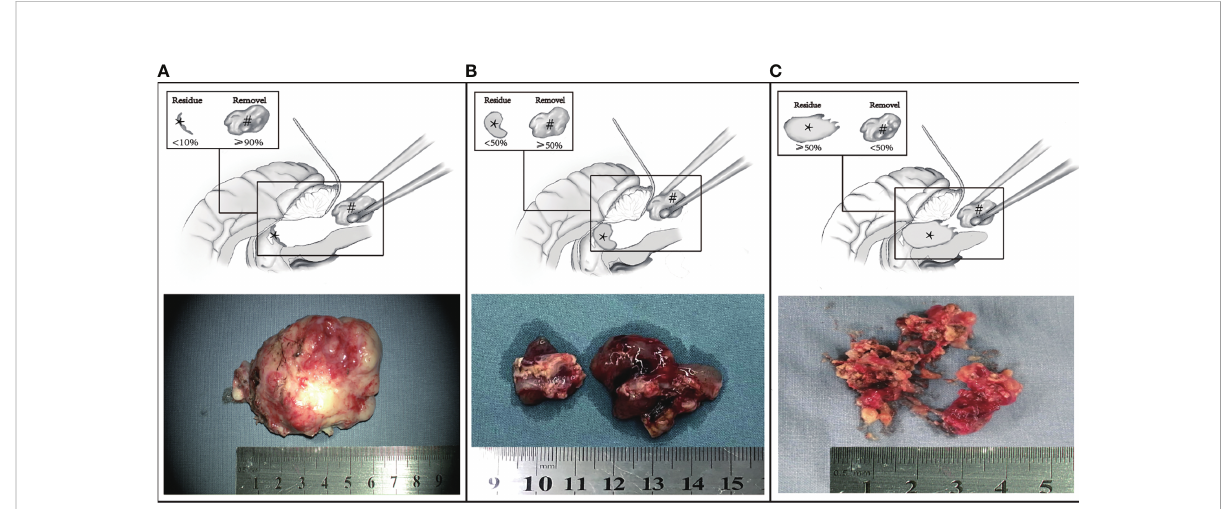
FIGURE 2 Three methods of resection. (A) Complete en bloc concept (marginal resection as a whole ≥ 90% and piecemeal resecting <10%). (B) Partial en bloc concept (marginal resection ≥ 50% and <90%). (C) Piecemeal concept (piecemeal resecting >50%). The black asterisk and black pound sign represent residual tumor and the part removed as a